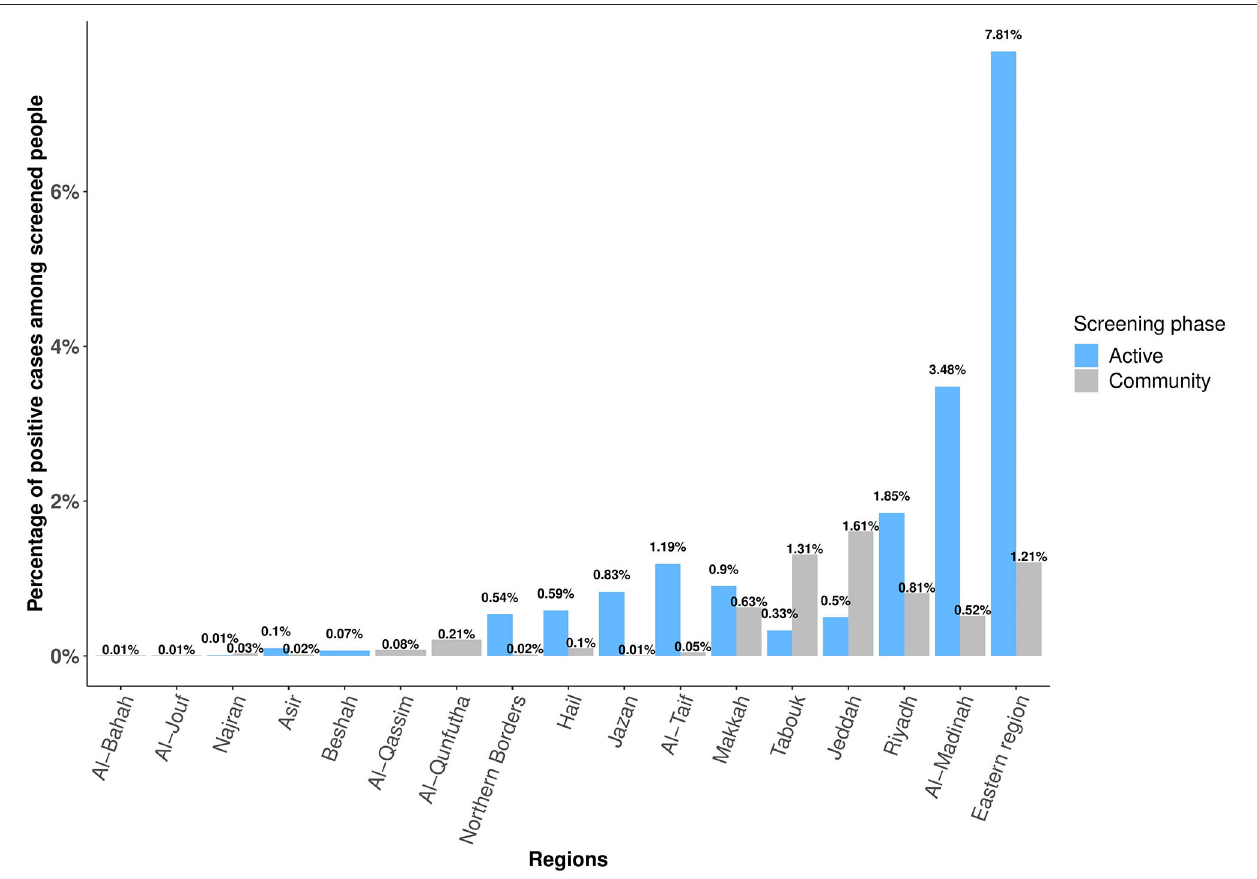
FIGURE 3 | The percentage of positive COVID-19 cases in different regions in Saudi Arabia between 16 April and 19 May 2020 among active and community phases of mass screenings.